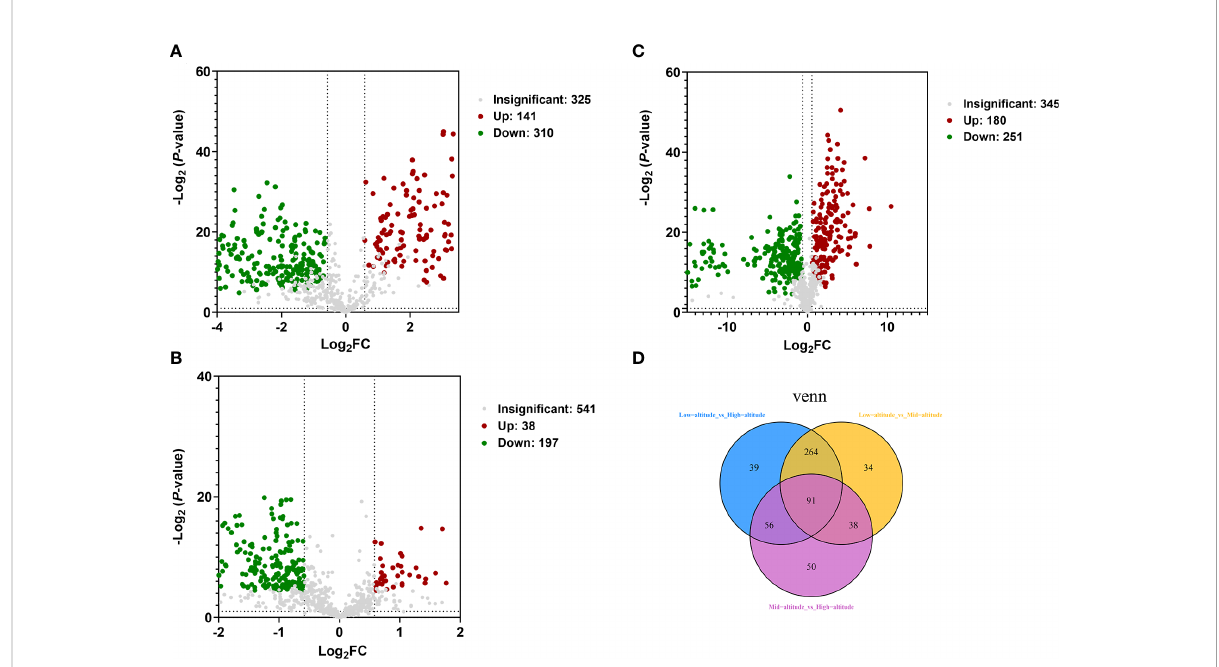
FIGURE 2 Volcano plot and Venn diagram were used to illustrate the number of differential metabolites. (A) Volcano plot of Low-altitude vs High-altitude. (B) Volcano plot of Low-altitude vs Mid-altitude. (C) Volcano plot of Mid-altitude vs High-altitude. (D) Venn diagram showed the common differential metabolites and unique differential metabolites at different